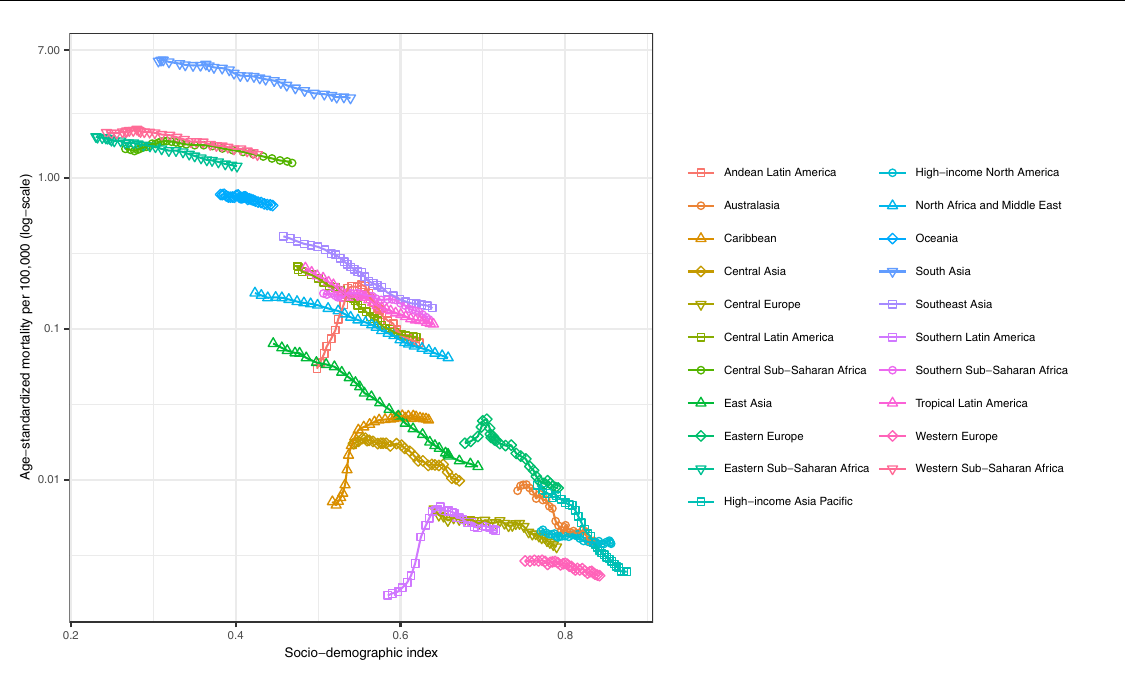
Fig. 3 | Regional age-standardized mortality rate from snakebite envenoming from 1990 to 2019 by Socio-demographic Index value of the region. Age- standardized snakebite envenoming mortality rate per 100,000 by region and